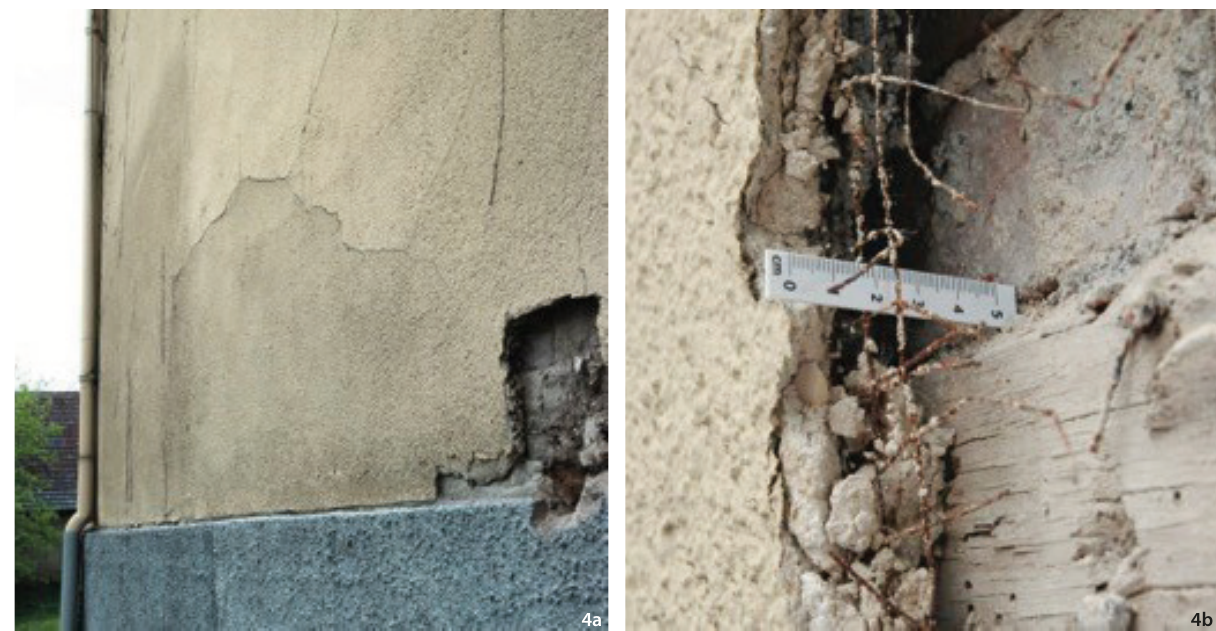
4a 4b Figure 4 Cement plaster applied in the 1950's. (Source: the author).